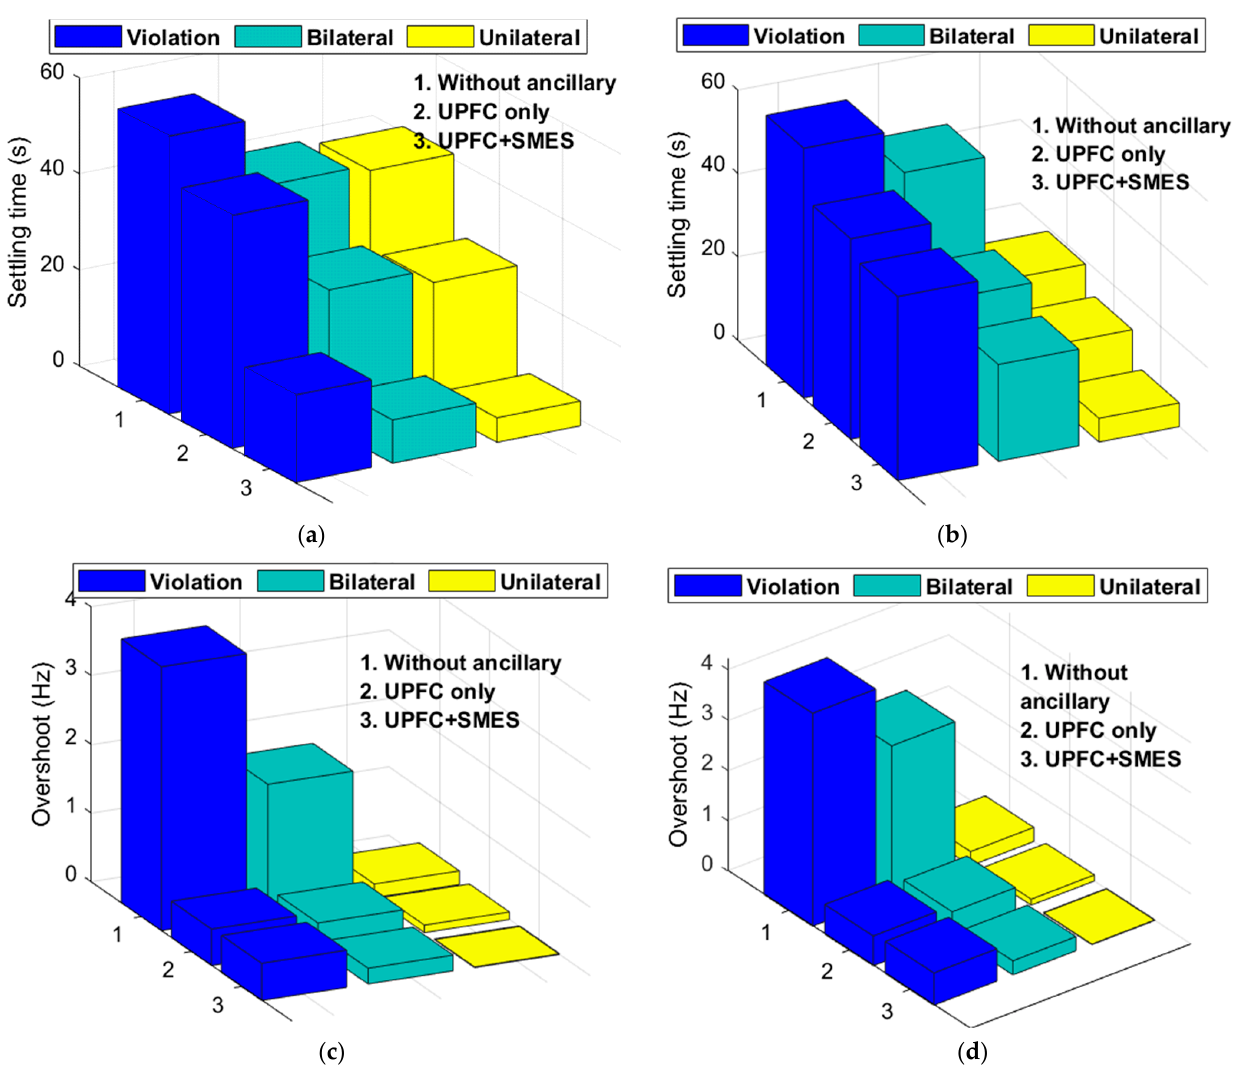
Figure 14. Transient response of frequency deviations in unilateral, bilateral, and contract violation scenarios: ( a ) frequency deviation in area-1 (setting time); ( b ) frequency deviation in area-2 (setting time); ( c ) frequency deviation in area-1 (overshoot); ( d ) frequency deviation in area-2